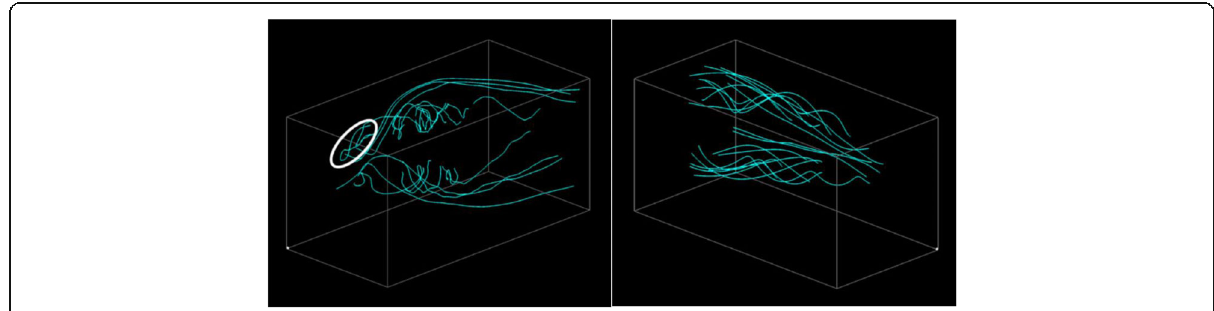
Evaluation of streamline evaluation schemes